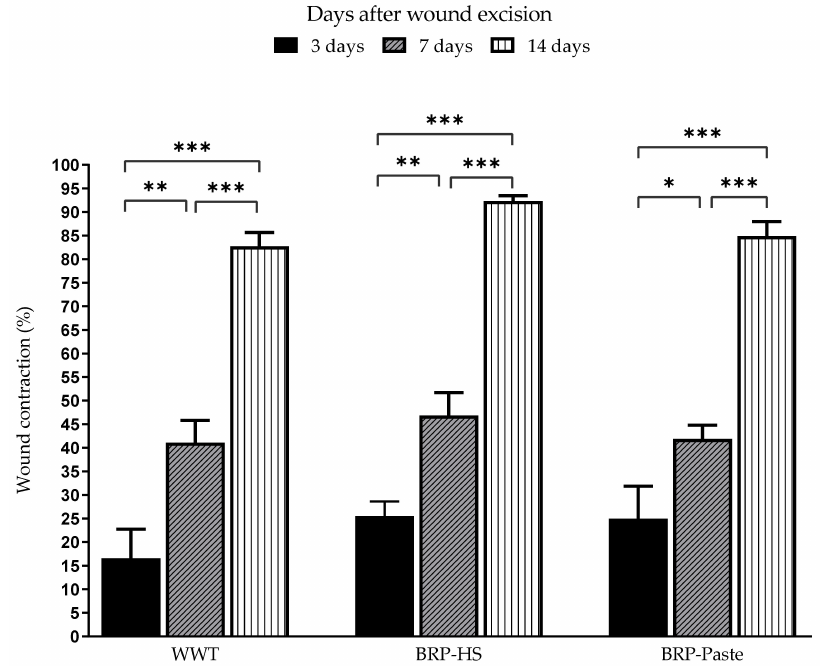
Figure 2. Wound contraction percentage of surgical skin wounds in Wistar rats treated over 3, 7 and 14 days. * p < 0.05, ** p < 0.01 and *** p < 0.001 in comparison to the WWT group by one-way analysis of variance (ANOVA) followed by Newman-Keuls test ( n =